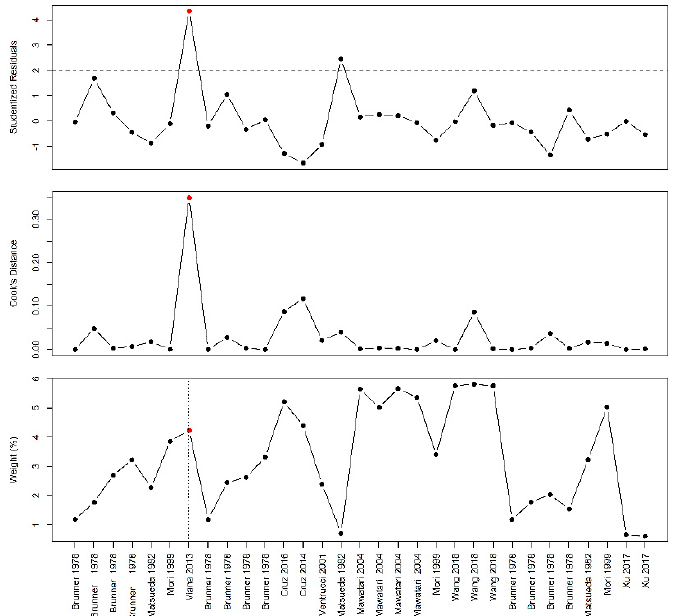
Figure A11. Sensitivity analysis of studies reporting on branched-chain amino acids supplementation and fetal/birth weight. Sensitivity analysis revealed Viana et al. [103] as an influential case.